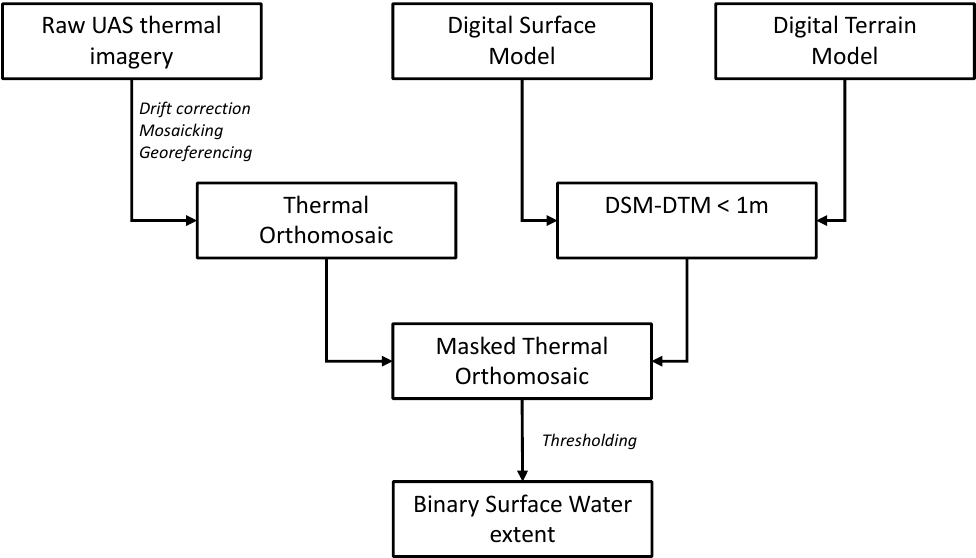
Figure 4. Flow chart of the surface water extent mapping workflow based on UAS thermal imagery.